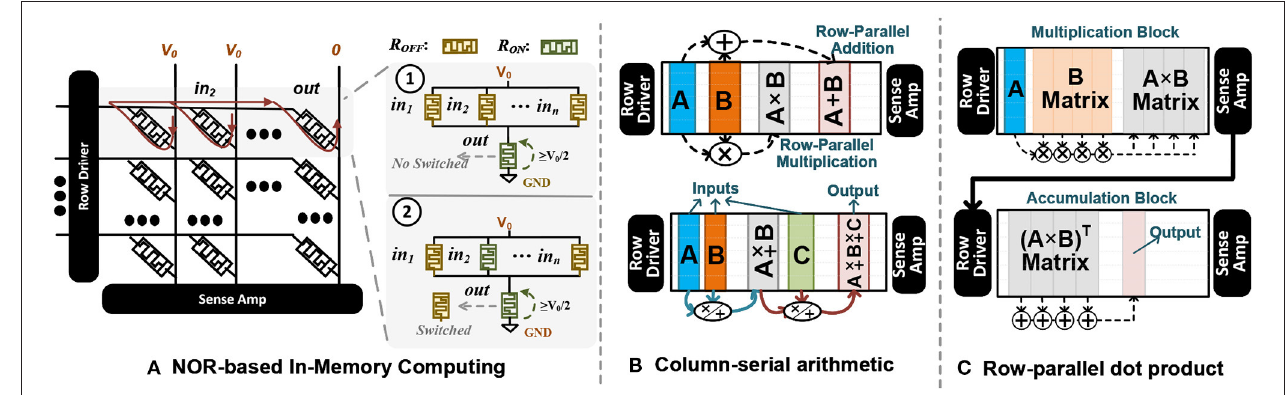
FIGURE 8 | (A) NOR-based in-memory computing using switching characteristic of NVM devices. (B) row-parallel arithmetic operations, including addition and multiplication, and (C) row-parallel dot product